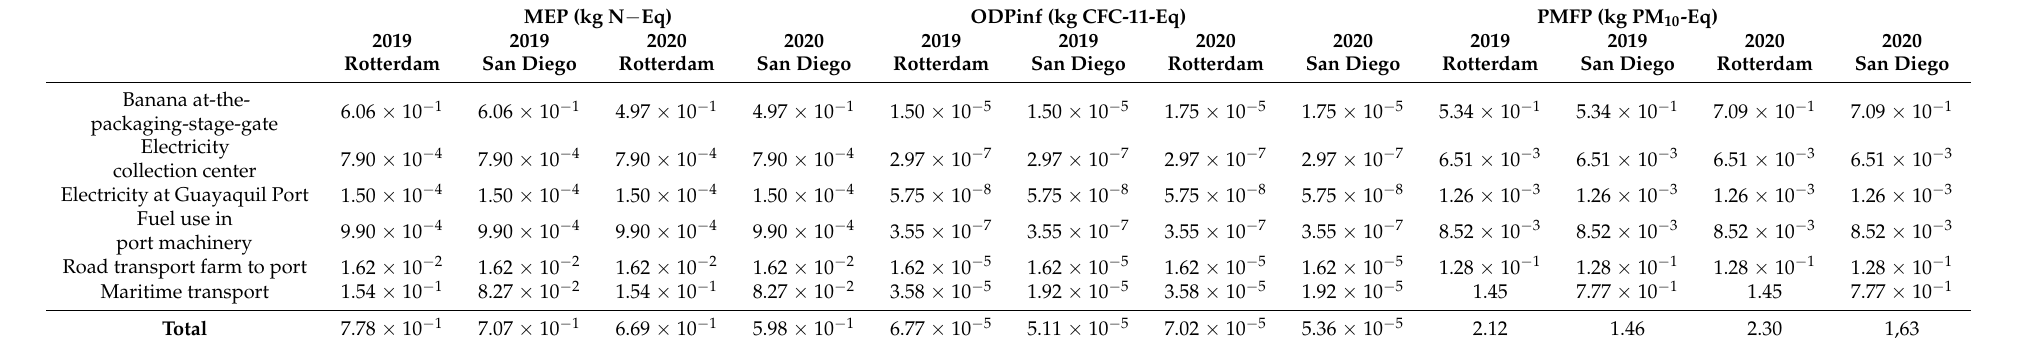
Table 7. Impact category indicator results for 1 ton of “Banana at-the-foreign-port” for years 2019 and 2020 for impact categories MEP, ODPinf, and